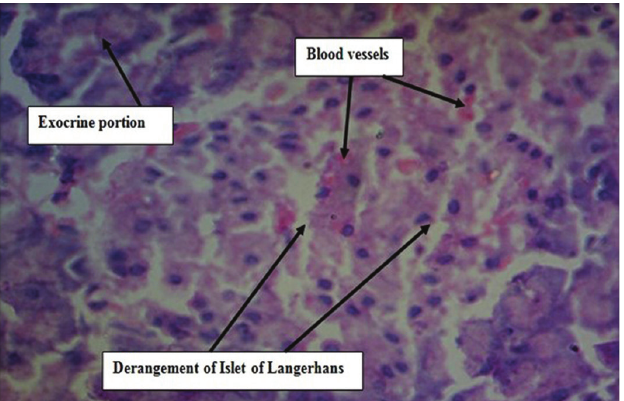
FIGURE 6 - Risperidone-induced histopathological changes in pancreas (H & E, 400x, 5 µ): Representative image of pancreas of rats treated with risperidone (2.5 mg/kg/d) orally for three weeks showing derangement of islets of Langerhans, lacking compaction of glandular cells as compared to rats treated with normal saline.